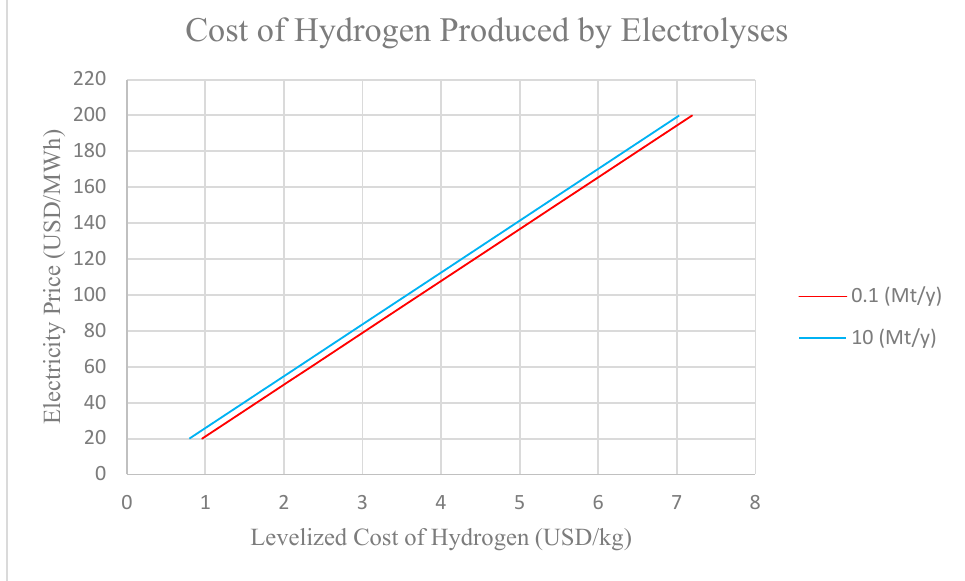
Figure 1. Levelized cost of hydrogen as a function of price for electricity (data from [23]).